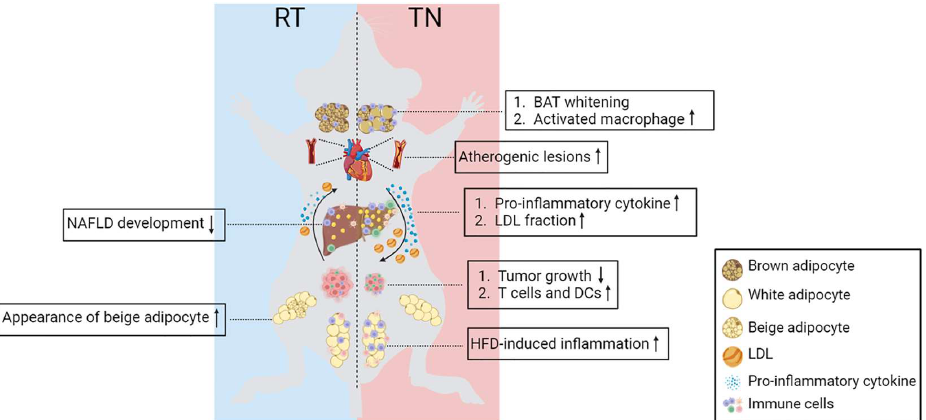
Figure 3. TN housing alters mice’s phenotype and response to the development of diseases. TN housing induces BAT and reduces the appearance of beige adipocytes in iWAT. Upon HFD feeding, TN housing exacerbates the accumulation of immune cells in eWAT and the liver. Housing the atherosclerosis mice model in their TN zone along with western-diet feeding leads to a greater accumulation of atherogenic lesions. TN housing reduced tumor growth in mice inoculated with tumor cells. These phenotypes might be due to the higher number of CD8+ T cells and activated DC infiltrated into the tumor cells. TN housing enhances circulating pro-inflammatory cytokines resulting in higher systemic inflammation. Furthermore, TN housing also alters the circulating cholesterol profile reflected by a higher fraction of LDL. RT: room temperature; TN: thermoneutral; BAT: brown adipose tissue; DCs: dendritic cells; NAFLD: non-alcoholic fatty liver diseases; HFD: high-fat diet; LDL: low-density